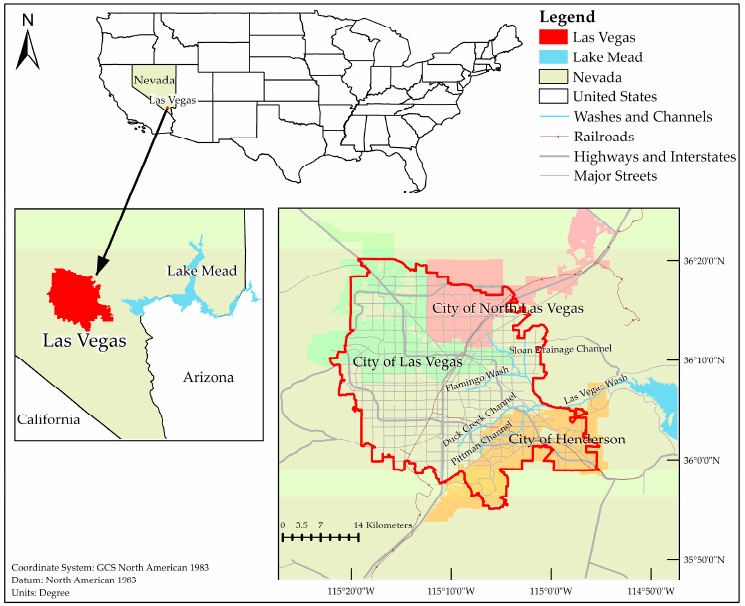
Figure 1. Geographical location of the study area: Las Vegas metropolitan area, Nevada.